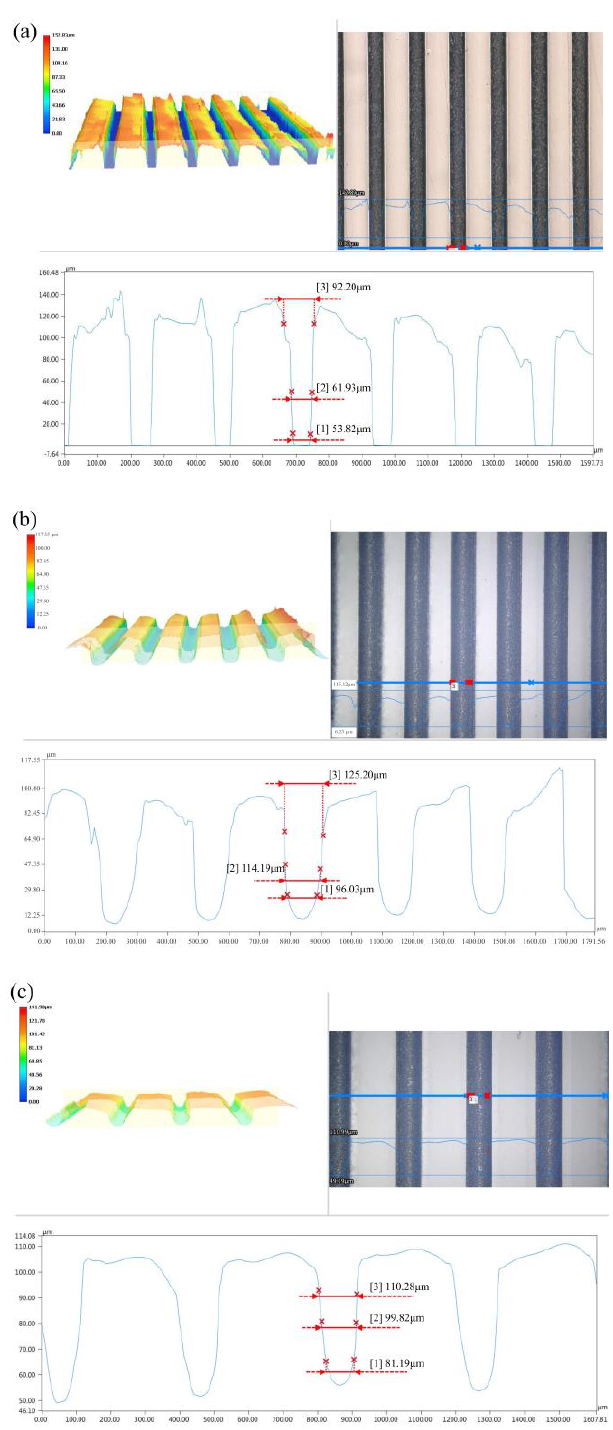
Figure 11. Three-dimensional (3D) topography and cross section of trapezoidal groove structures (×200): ( a ) sample 1-3, ( b ) sample 1-4 and ( c ) sample 1-6. ( × 200): ( a ) sample 1-3, ( b ) sample 1-4 and ( c ) sample